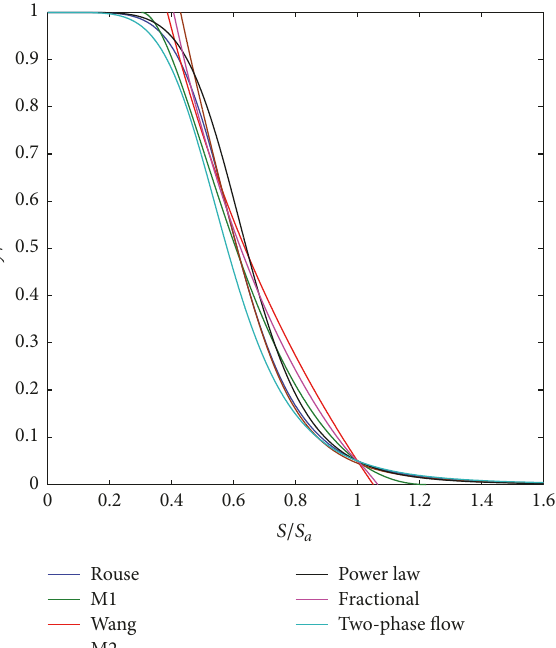
Figure 3: Numerical results of different models in describing the vertical distribution of sediment suspension. Von Karman constant 𝜅 = 0.4 , shear velocity 𝑢 ∗ = 0.15 , sediment settling velocity 𝜔 = 0.01 , water depth ℎ = 1.0 , 𝑎 = 0.05ℎ , and 𝛼 = 0.9 in the fADE model. For description simplicity, units are not used for parameters in this